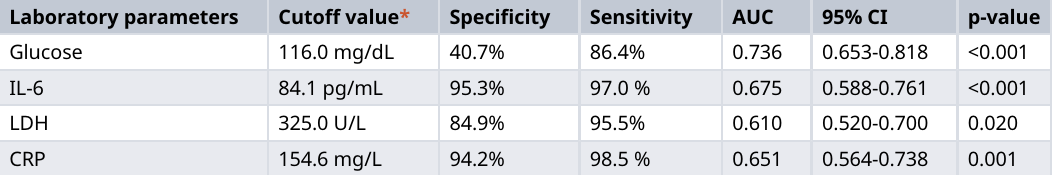
Table 3. ROC curve analysis of clinical laboratory